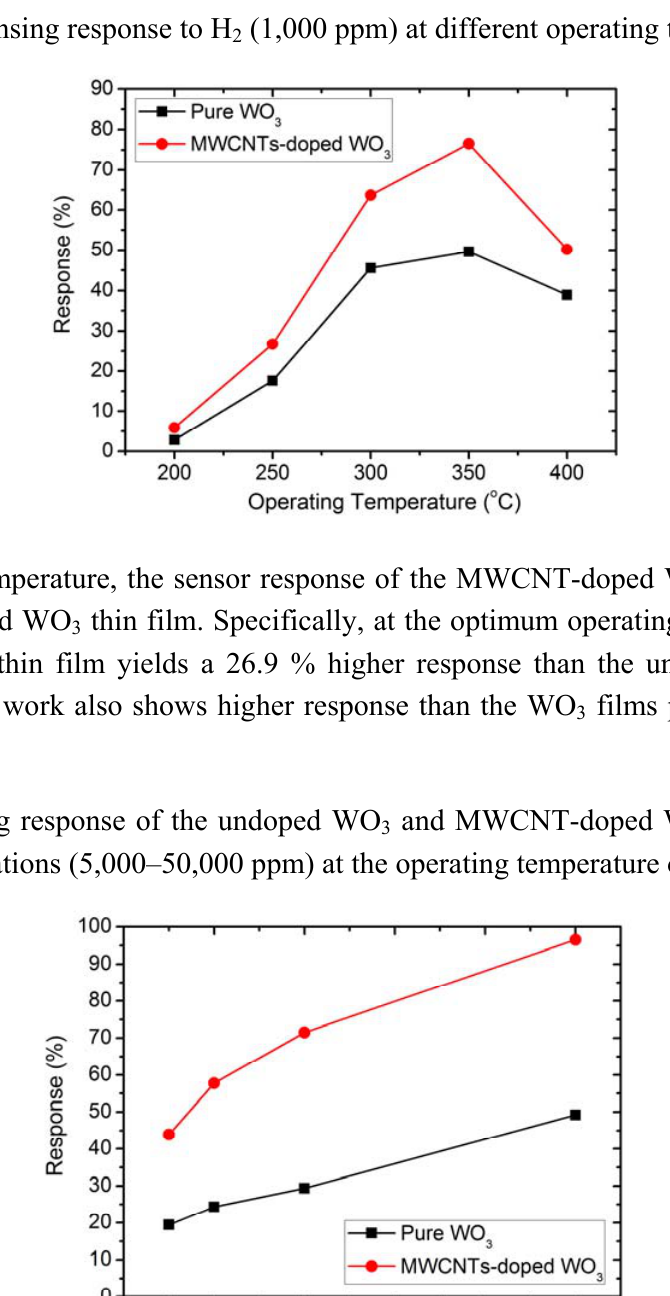
Figure 5. Sensing response to H